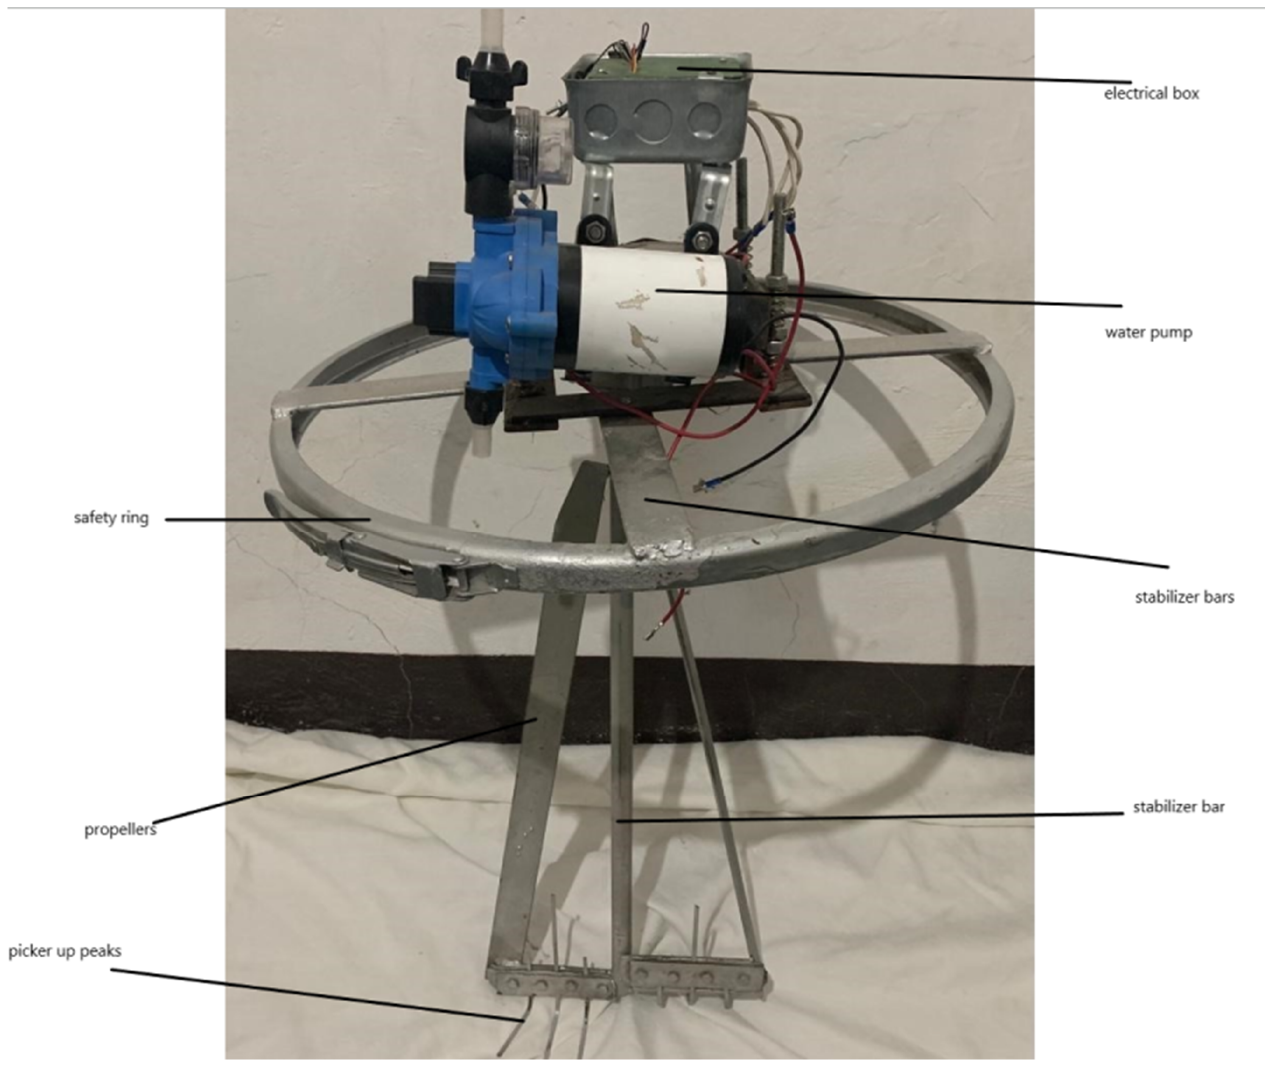
Figure 2. Real view of the mechanical device.